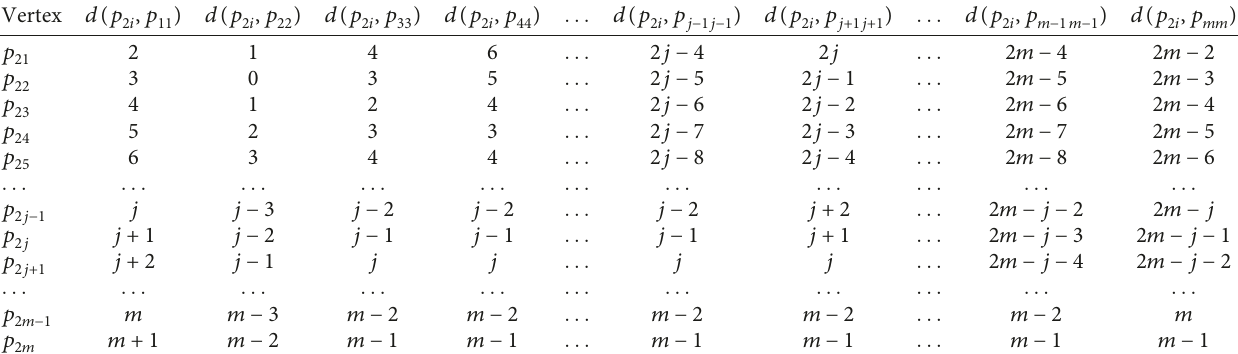
( M ) of vertices in the second cluster for 1 ≤ i ≤ m . p 2 i jj